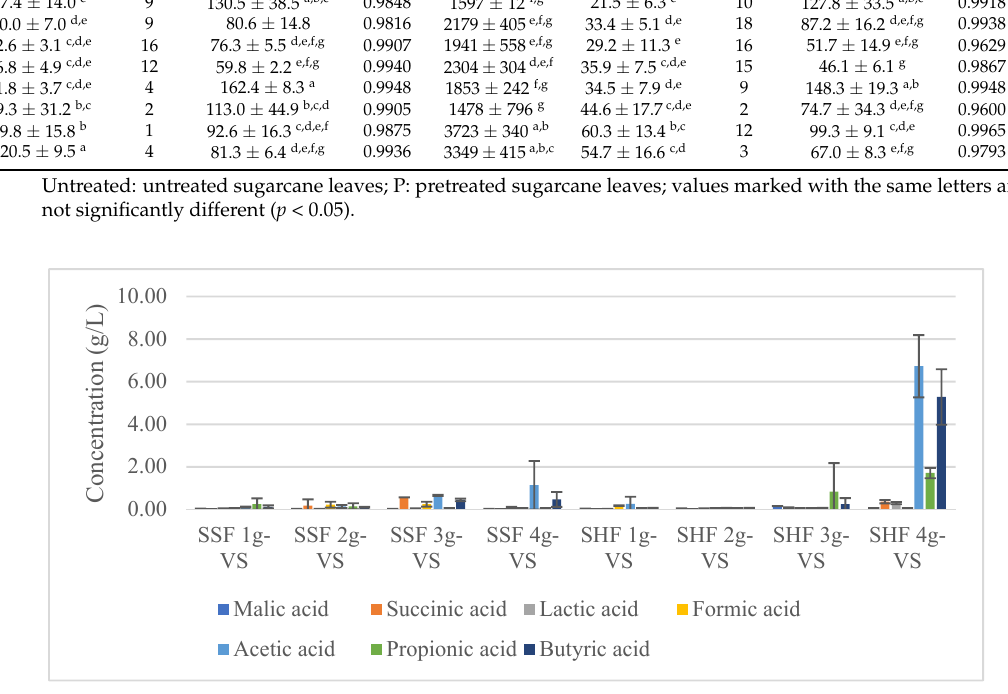
Figure 2. Comparison of soluble metabolite production in SSF and SHF one-stage methane production using DES-pretreated sugarcane leaves with substrate loading variations .